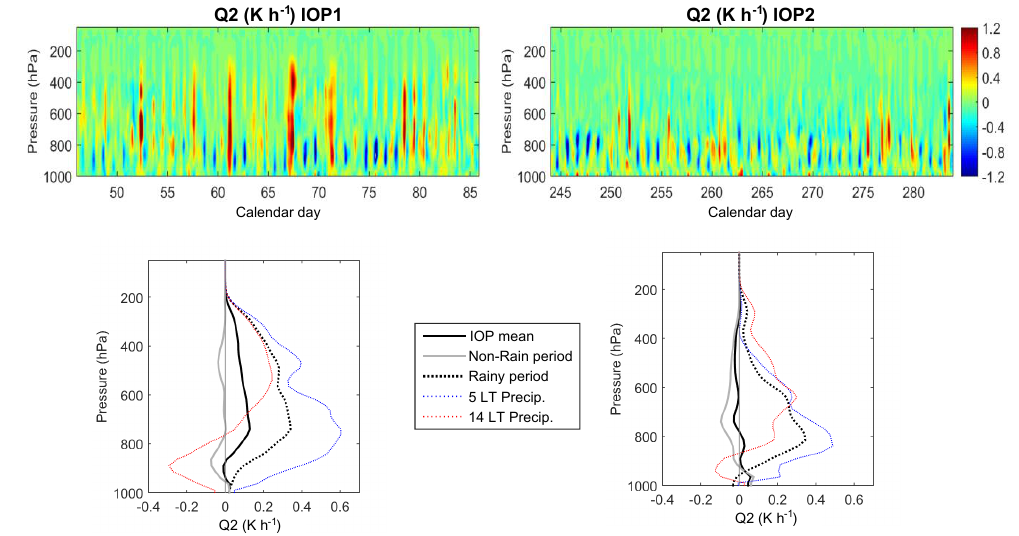
Figure 6. The time series (top) and temporal mean profiles (bottom) of apparent moisture sink Q 2 for IOP1 (left) and IOP2